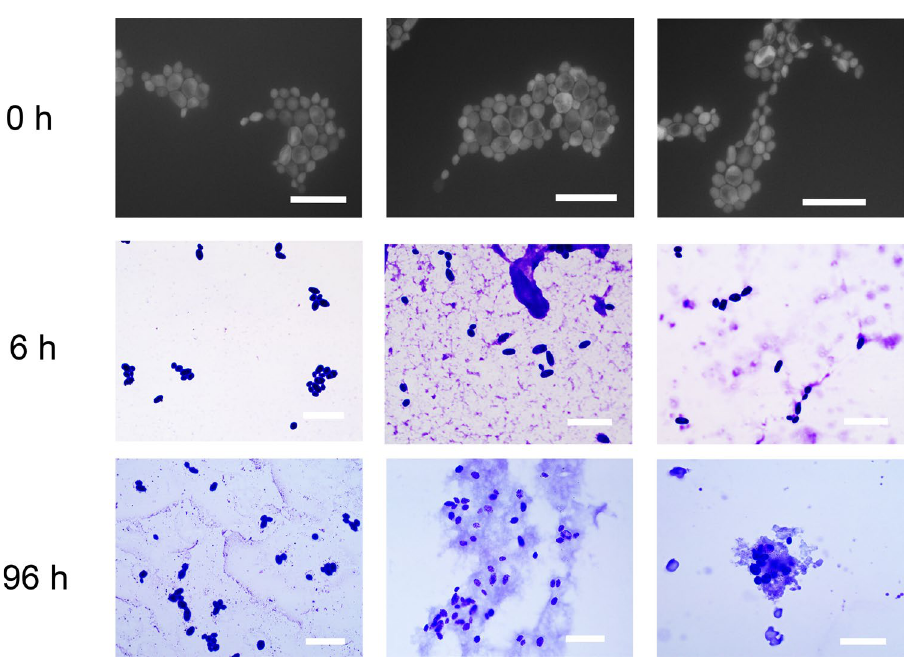
Figure 7. Cell culture of S. cerevisiae in the buffer solution, the lysozyme solution and the crystallisation solution (protein solution mixed with precipitation solution) from left to right columns, respectively, with scale bar of 20